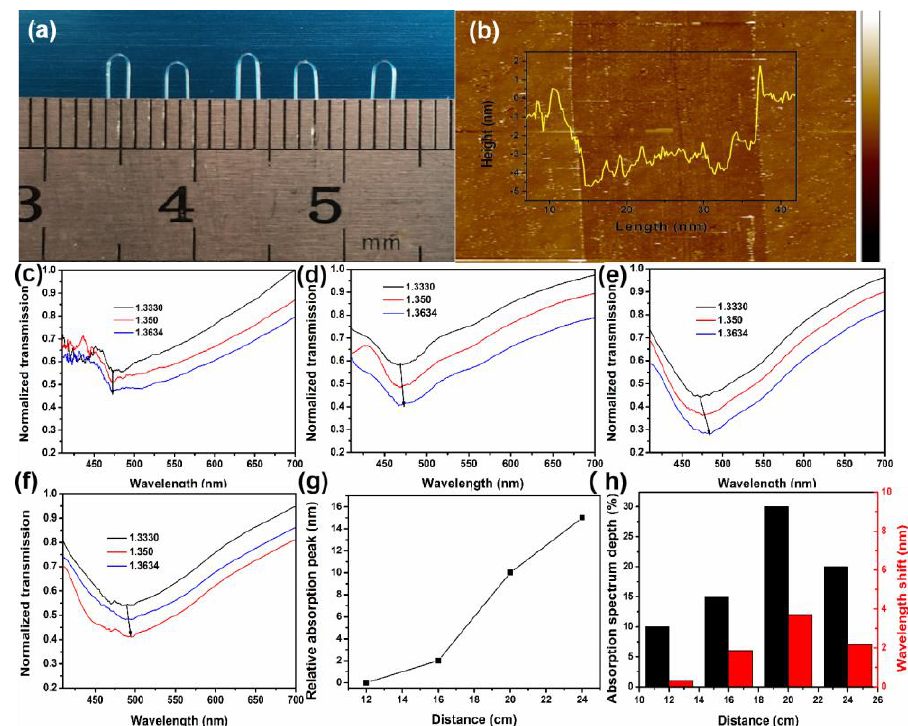
Figure 3. ( a ) The inner diameter of the U-bent bare optical fiber. ( b ) Atomic force microscopy (AFM) of Au film on the U-bent fiber. ( c – f ) The absorption spectra of ITO-NM/U-bent/0.04/12, ITO-NM/U-bent/0.04/16, ITO-NM/U-bent/0.04/20, and ITO-NM/U-bent/0.04/24 sensors in alcohol solution with RI from 1.3330 to 1.3634. ( g ) Absorption spectrum movement trend graph (475 nm as the origin). ( h ) Histogram of the absorption spectra depth and displacement distance corresponding to the different metamaterial sensors at different locations.